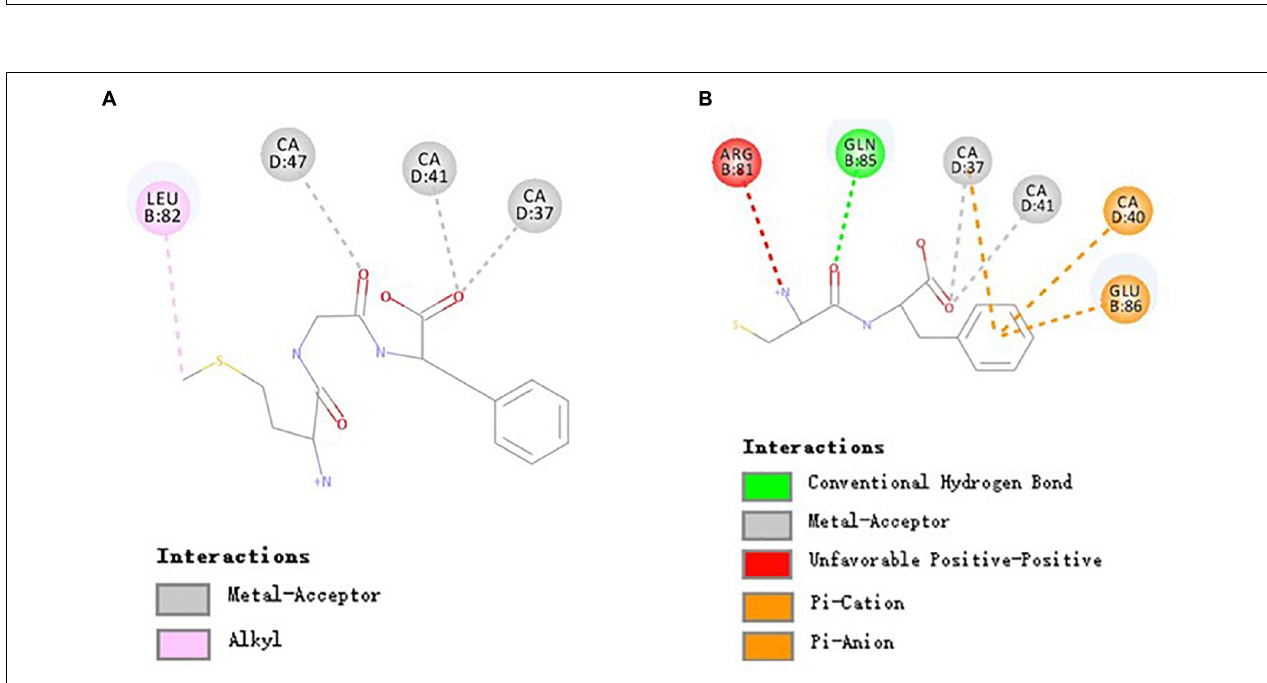
FIGURE 4 | Molecular interactions of MGF, CF, and EPCR. (A) Molecular interactions of MGF and EPCR. (B) Molecular interactions of CF and EPCR.